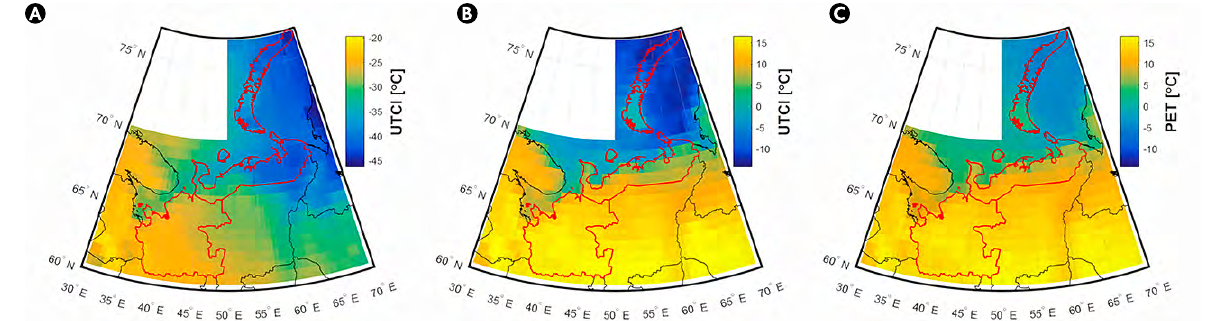
Figure 3. Mean UTCI-values in January (A) and July (B), mean РЕТ-values in July (C)